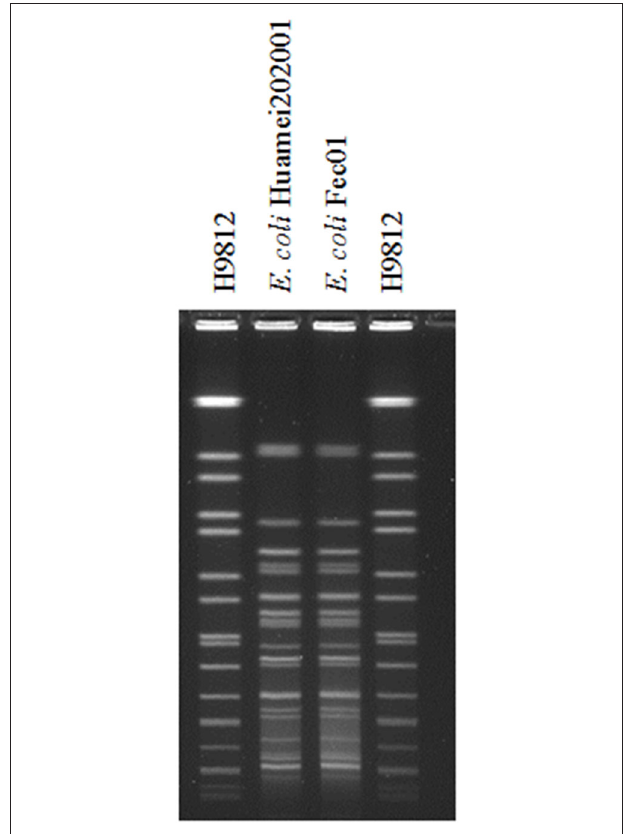
FIGURE 1 | PFGE fingerprinting between strain E. coli Huamei202001 and strain E. coli Fec01, H9812: Salmonella H9812 molecular